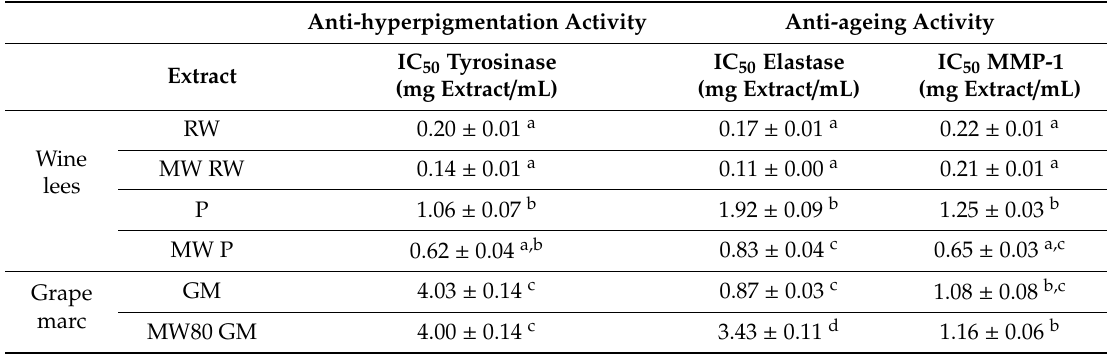
Table 3. The IC 50 values of extracts towards tyrosinase, elastase and MMP-1. The results identified with di ff erent letters (a to d) in the same column are statistically di ff erent ( p -value ≤ 0.05). Anti-hyperpigmentation Activity Anti-ageing